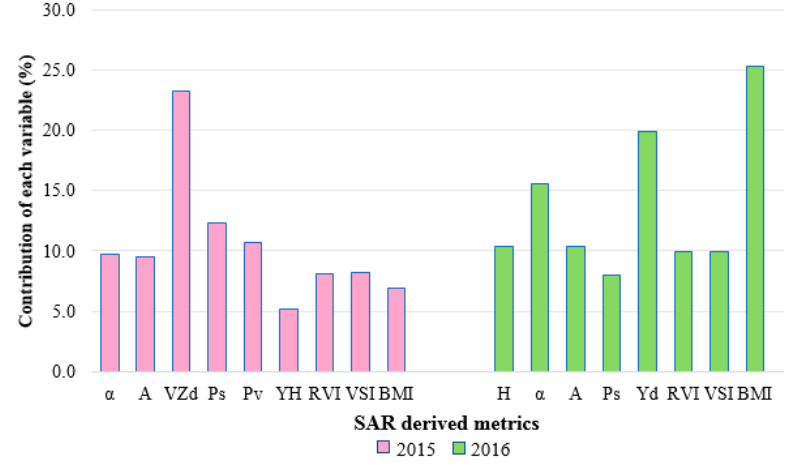
Figure 5. Contribution of each variable derived from PC1 and PC2. Details of the SAR derived metrics are presented in Table 3.